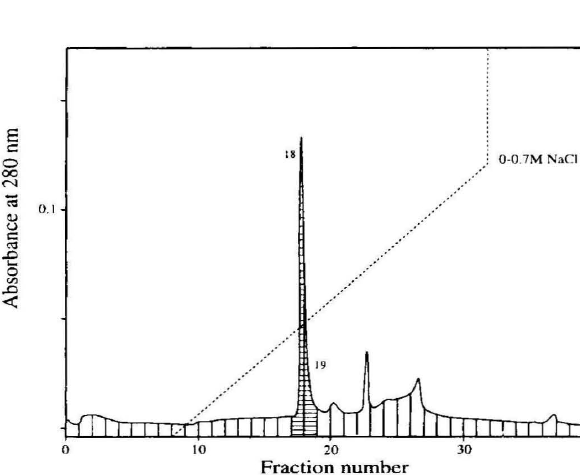
Table 1 represents a summary of the purifica tion of sepiapterin deaminase from the integu ment of the lemon mutant lanrae of the silkworm.